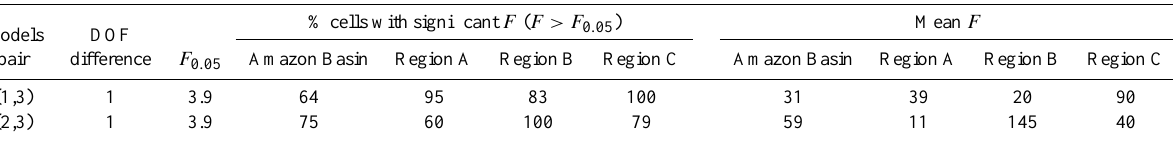
Table 3. Statistical comparison between different models pairs using an F test ( p < 0 . 05). See Fig. S3 in the Supplement for the distributed F values.